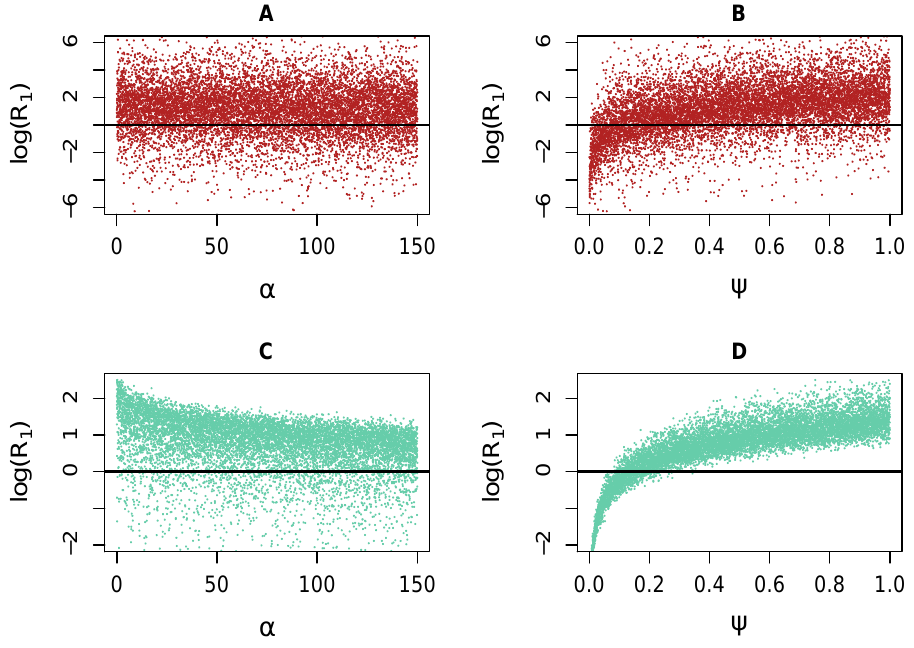
Figure 8. Scatter plots associated with Figure 7 using LHS-sampled data (each dot is a simulation). Top row: initial case. Bottom row: revised case. Note the different vertical scales in each plot. The threshold R 1 = 1 is depicted with a horizontal line. ( A ): approximately uniform distribution of α in the initial ranges. ( B ): increasing trend in ψ in the initial trend, but no range exists wholly below the threshold. Note the distinct trend captured for ψ in the lower right figure ( D ): sufficiently small values of ψ correspond to the case of no coexistence, regardless of the values of other parameters. Conversely, sufficiently large values of ψ will guarantee coexistence. The same properties do not apply to α ( C